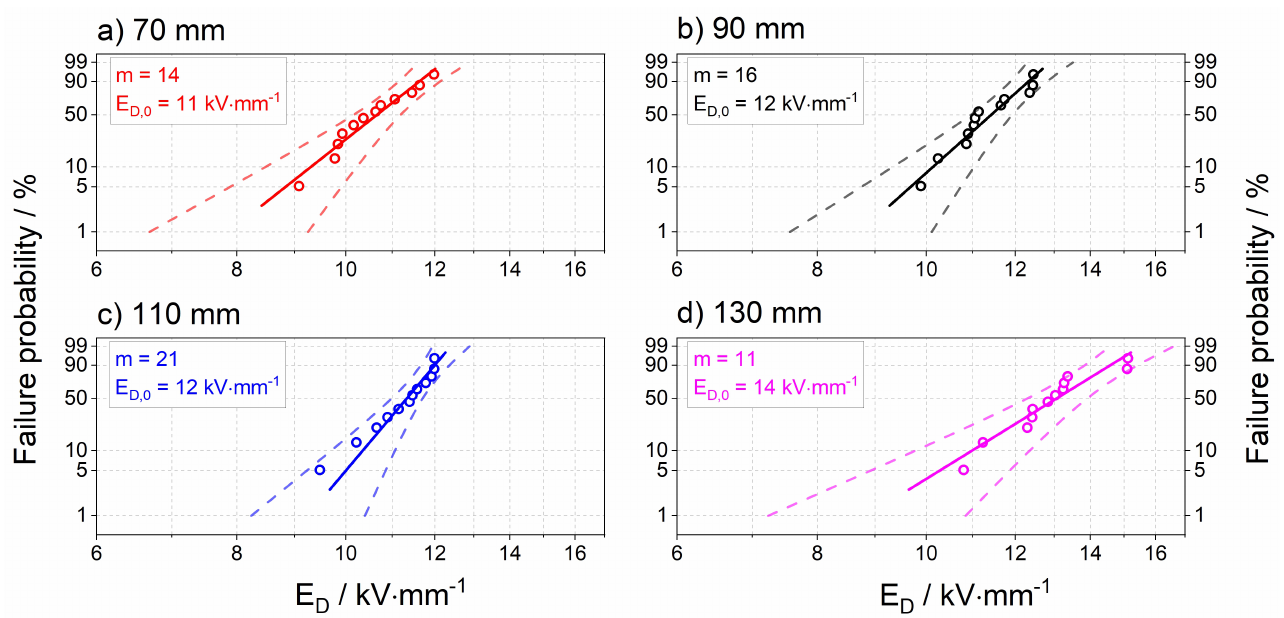
Figure 8. Weibull density function of Al 2 O 3 coatings at different spray distances with corresponding Weibull parameters m and E D ,0